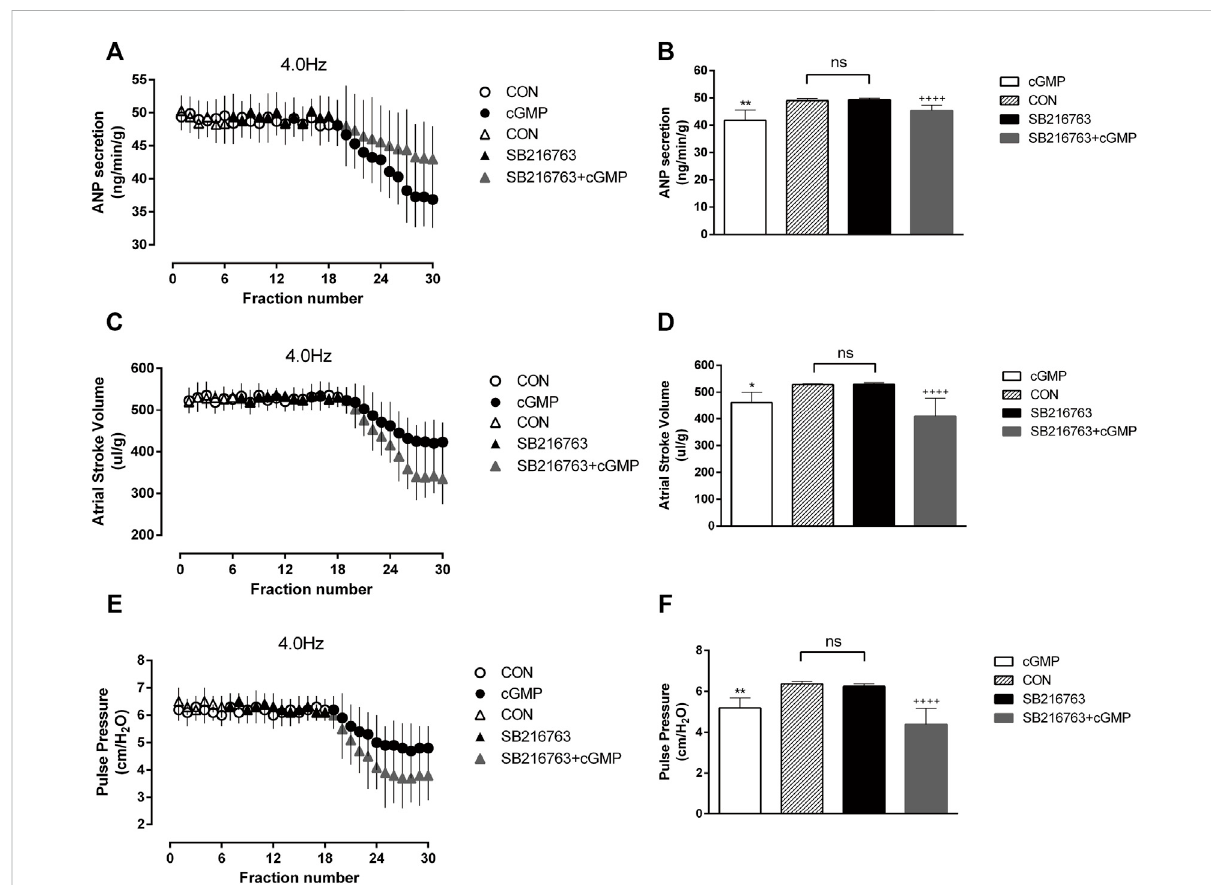
FIGURE 10 Effects ofSB216763 oncGMP-induced ANPsecretion andatrialdynamics underhigh-frequencystimulation. (A) Effects oftheGSK-3 β inhibitor SB on ANP secretion under high-frequency stimulation. (B) Quantitative analysis of the effects of SB on ANP secretion under high-frequency stimulation. ** p < 0.01 vs. SB + cGMP; ++++ p < 0.0001 vs. SB. (C) Effects of GSK-3 β inhibitor SB on atrial stroke volume under high-frequency stimulation. (D) Quantitative analysis of the effects of SB on atrial stroke volume under high-frequency stimulation. * p < 0.05 vs. SB + cGMP; ++++ p < 0.0001 vs. SB. (E) Effects of SB on atrial pulse pressure under high-frequency stimulation. (F) Quantitative analysis of the effects of SB216763 on atrial pulse pressure under high-frequency stimulation. ** p < 0.01 vs. SB + cGMP; ++++ p < 0.0001 vs. SB. Data are expressed as mean ± SEMs, n = 6. (PS CON and cGMP are from Figure